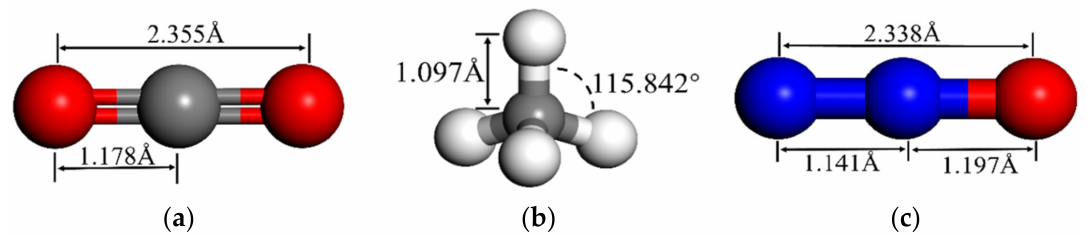
Figure 1. Gas molecular structure. ( a ) CO 2 ; ( b ) CH 4 ; ( c ) N 2 O.